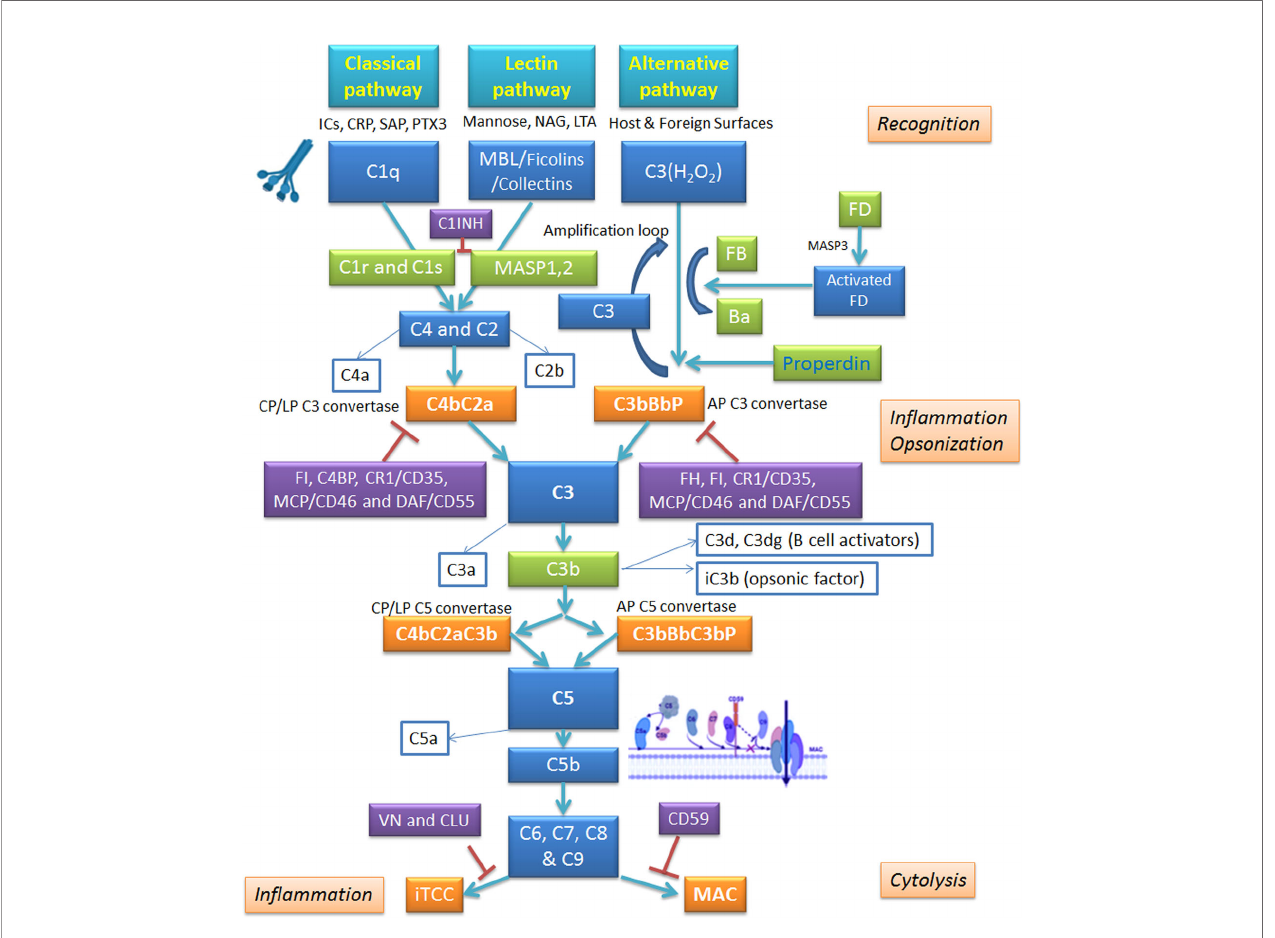
FIGURE 2 | Schematic overview of the complement system and its regulators. The complement system operates via three pathways: classical, alternative and lectin. Classical pathway is triggered by binding of C1q to antigen-antibody complex; alternative pathway involves autoactivation of C3, whereas lectin pathway is set in motion by Mannan-Binding Lectin (MBL) interaction with carbohydrate patterns on pathogen surface. All pathways converge on C3 convertase; from there, they follow identical routes of the cascade. The complement activation is kept in check by inhibitory regulators. AP, alternative pathway; CLU, clusterin; CP, classical pathway; CRP, C-reactive protein; CR1, complement receptor 1; C1INH, C1 inhibitor; DAF, decay-accelerating factor; FB, factor B; FD, factor B; FH, factor H; FI, factor I; ICs, immunocomplexes; iTCC, inactive terminal C complex; LP, lectin pathway; LTA, lipoteichoic acid; MAC, membrane attack complex; MCP, membrane cofactor protein; NAG, N-acetylglucosamine; PTX3, pentraxin 3; SAP, serum amyloid P component; VN,